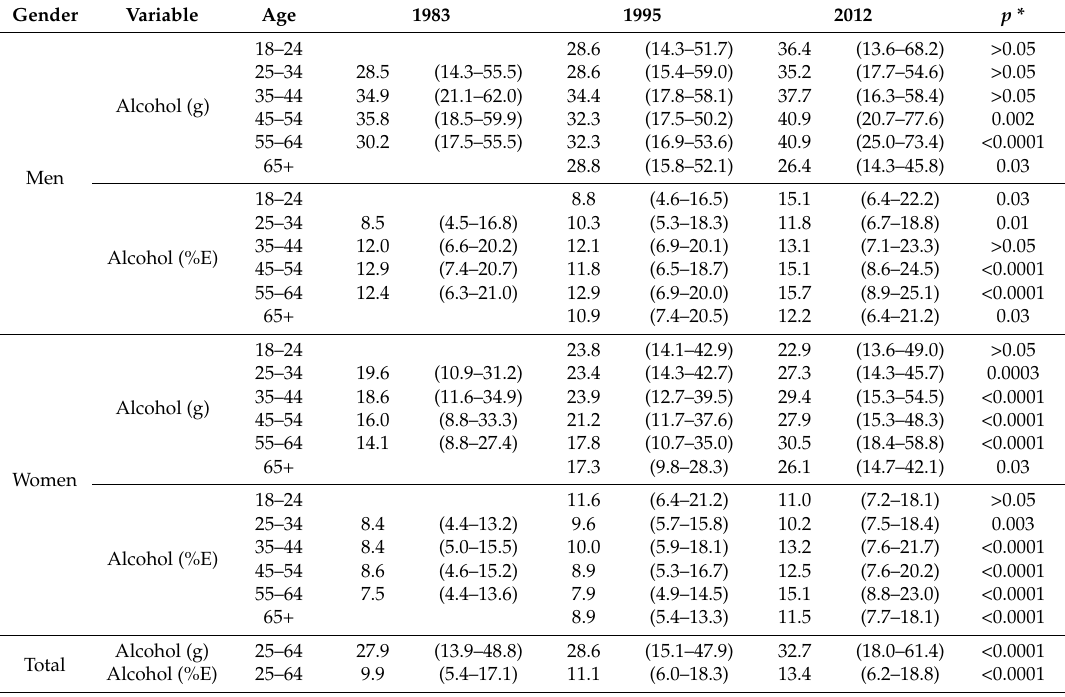
Table 3. Per-consumer median (IQR) pure alcohol (g) and energy contribution of alcoholic beverages (%) for participants of three national nutrition surveys from 1983, 1995, and 2011/12.